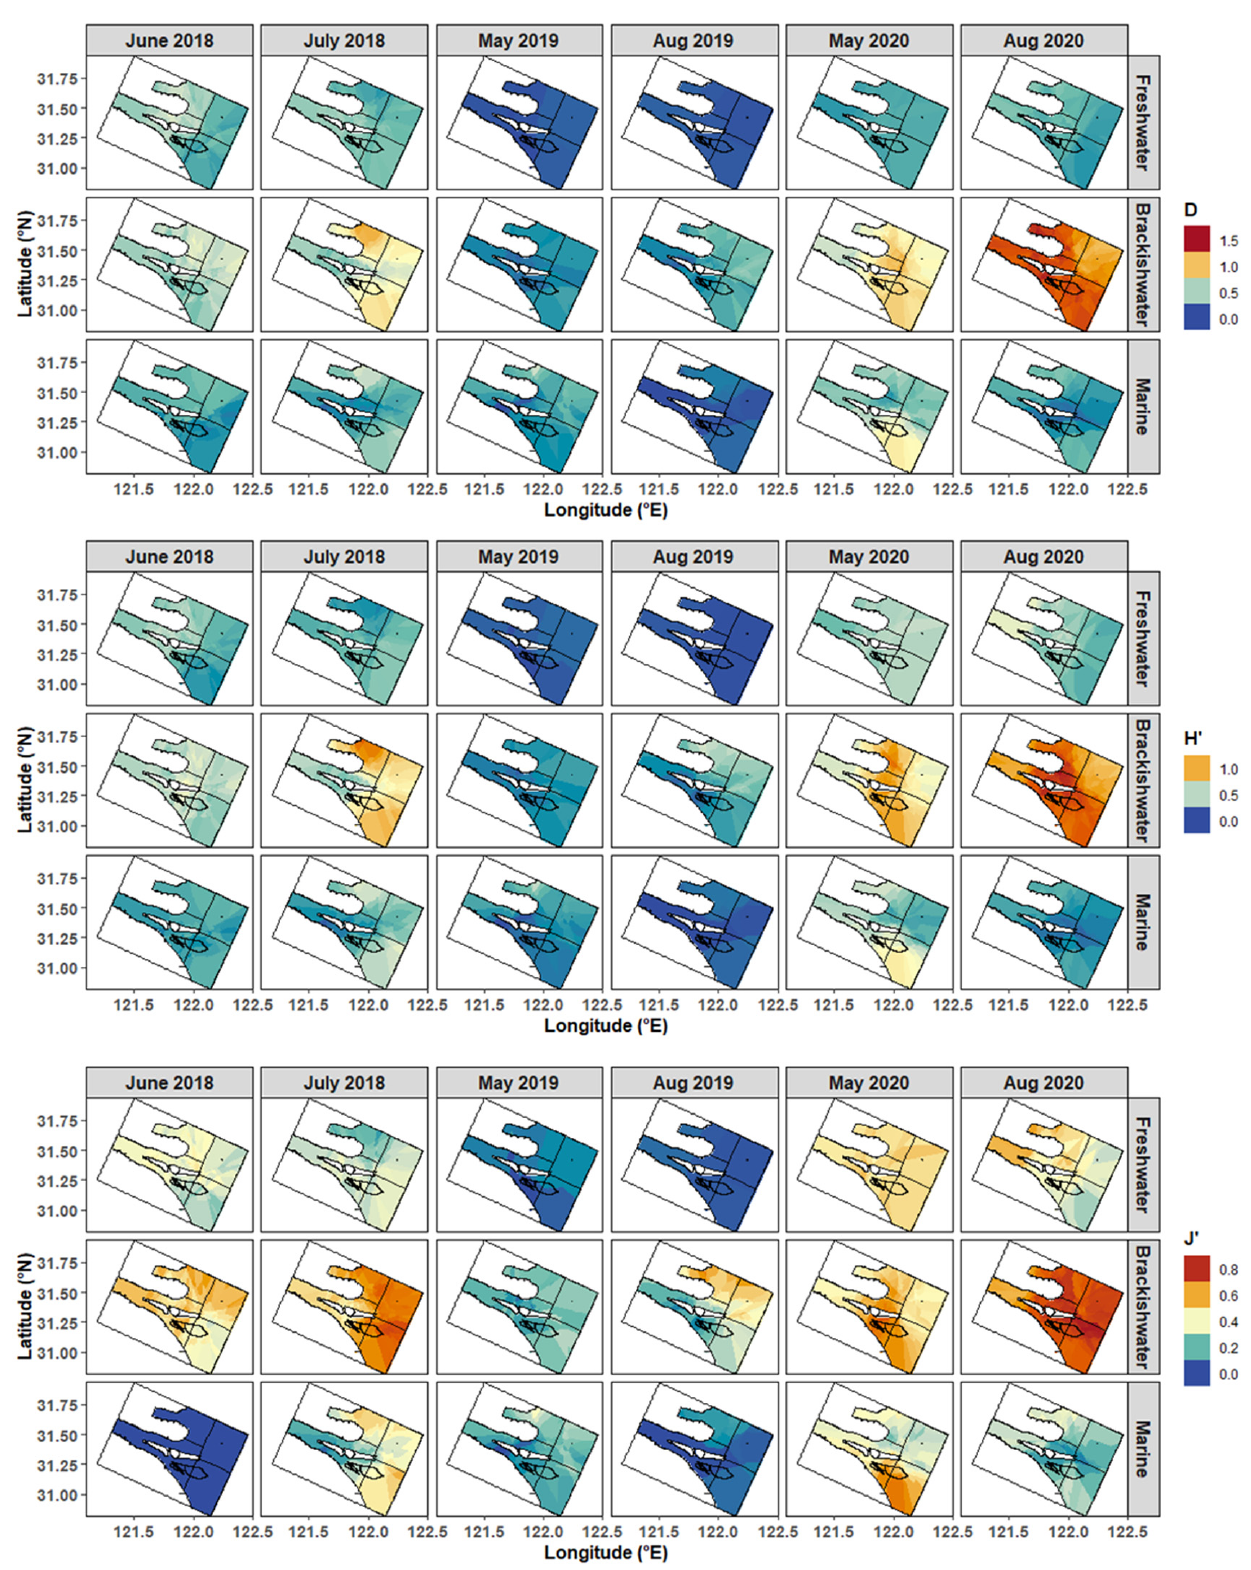
Figure A2. The distribution of Margalef’s richness (D), Shannon–Wiener index (H'), and Pielou’s evenness (J') with different ecological guilds in the Yangtze Estuary.